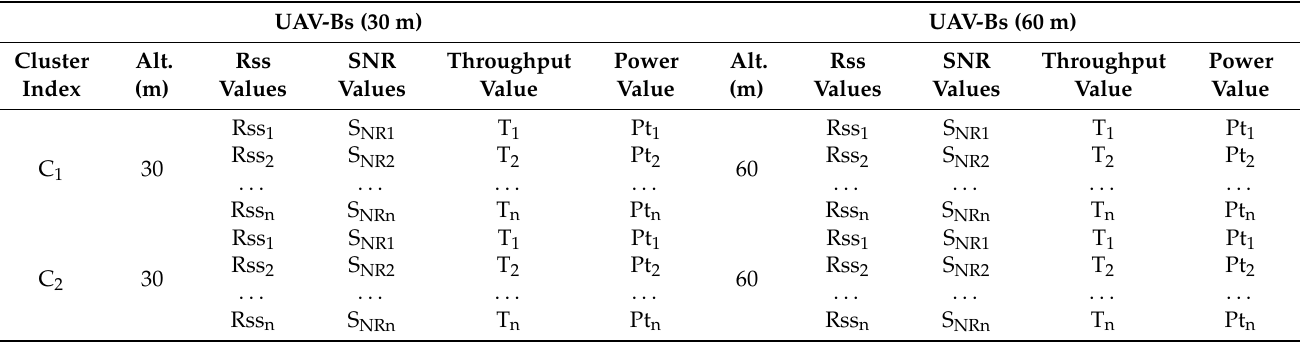
Table 1. Description of record values for training datasets.